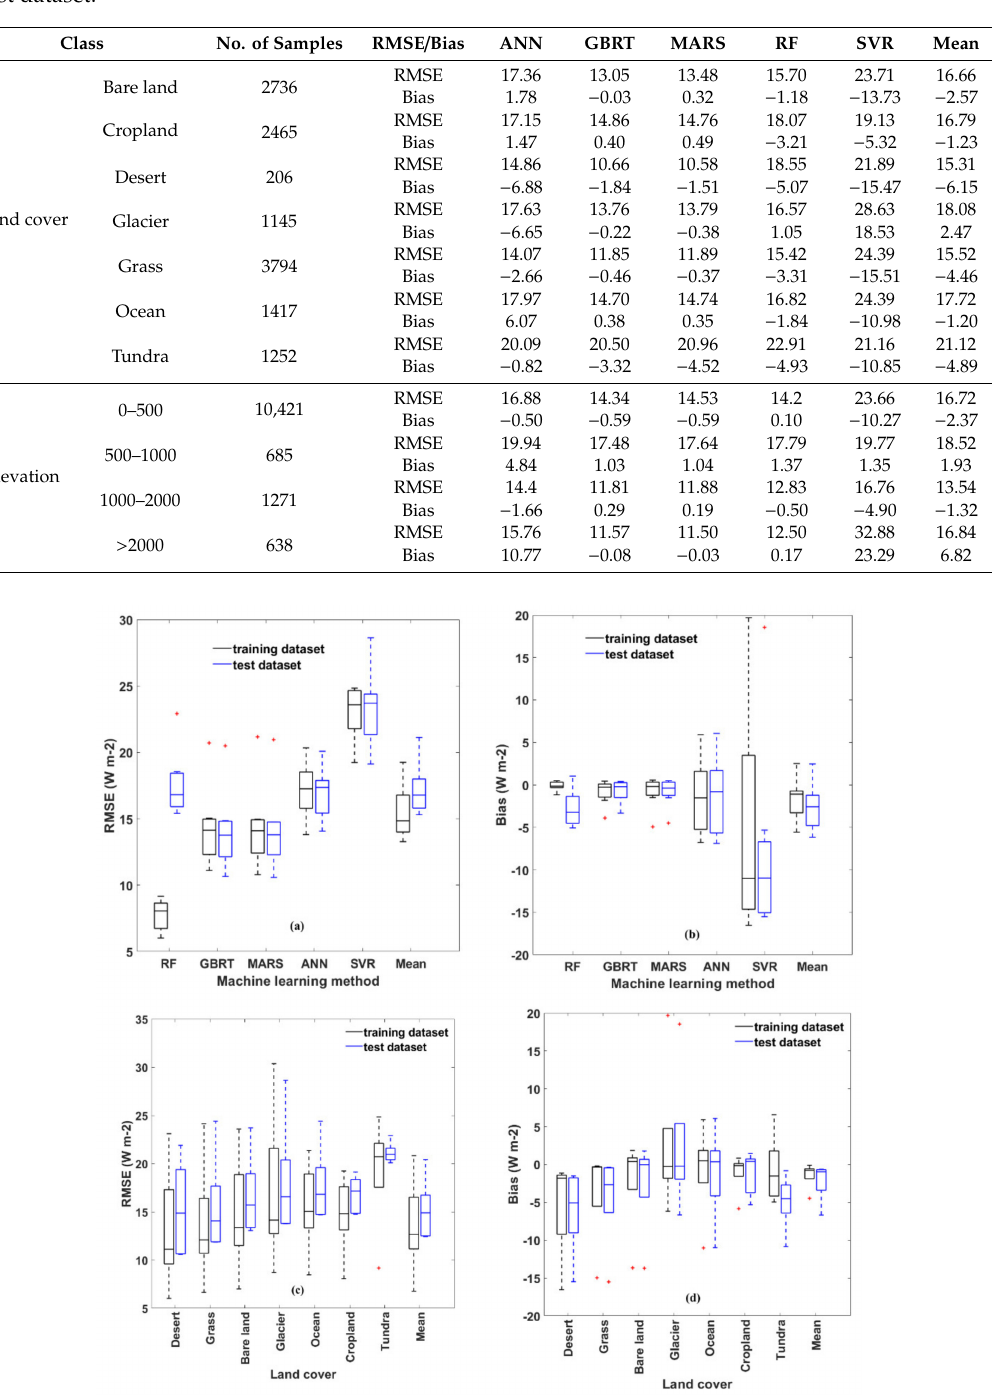
Table 4. Averaged RMSE and bias (W m − 2 ) of sites with same land cover type or elevation on the test dataset.